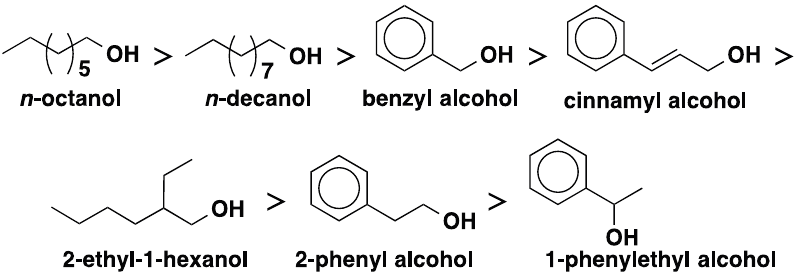
Figure 5. Order of reactivity of various alcohols in CALB-catalyzed transesterification of vinyl